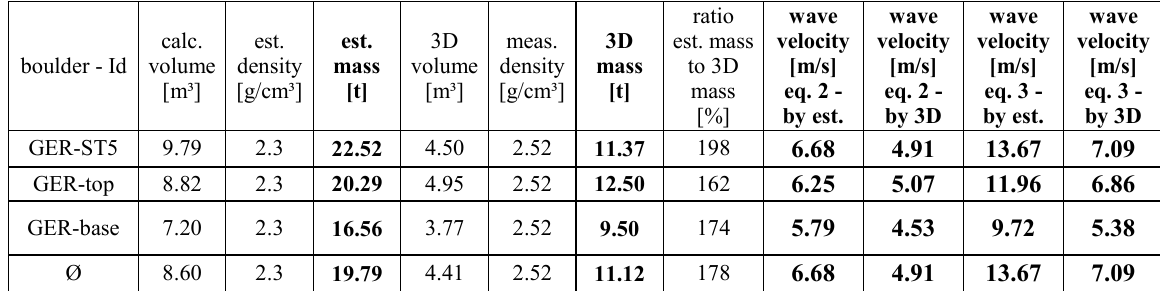
Table 3: Results of the different estimations (est.) and calculations by 3D-reconstruction (3D) of the dislocated